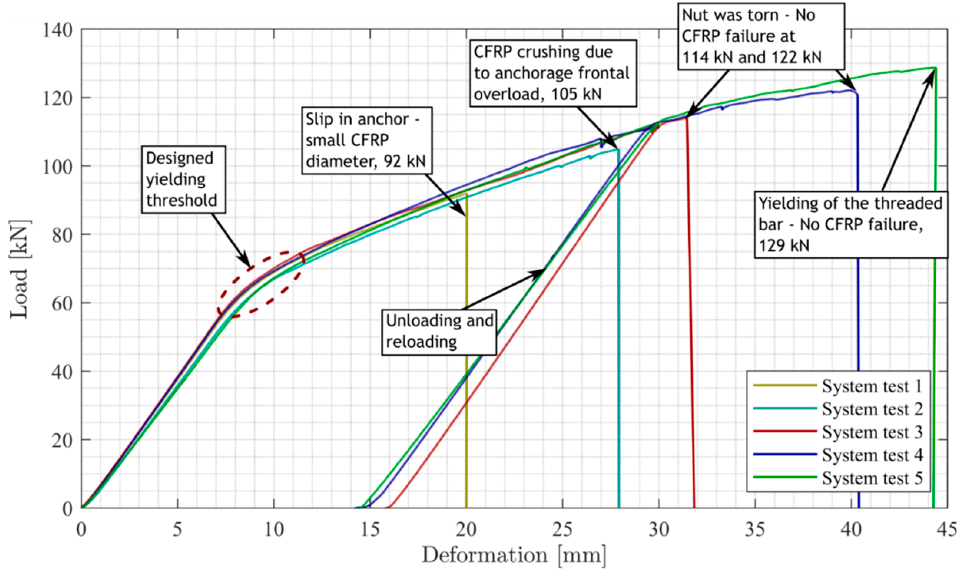
Figure 13. Load deformation test curves.